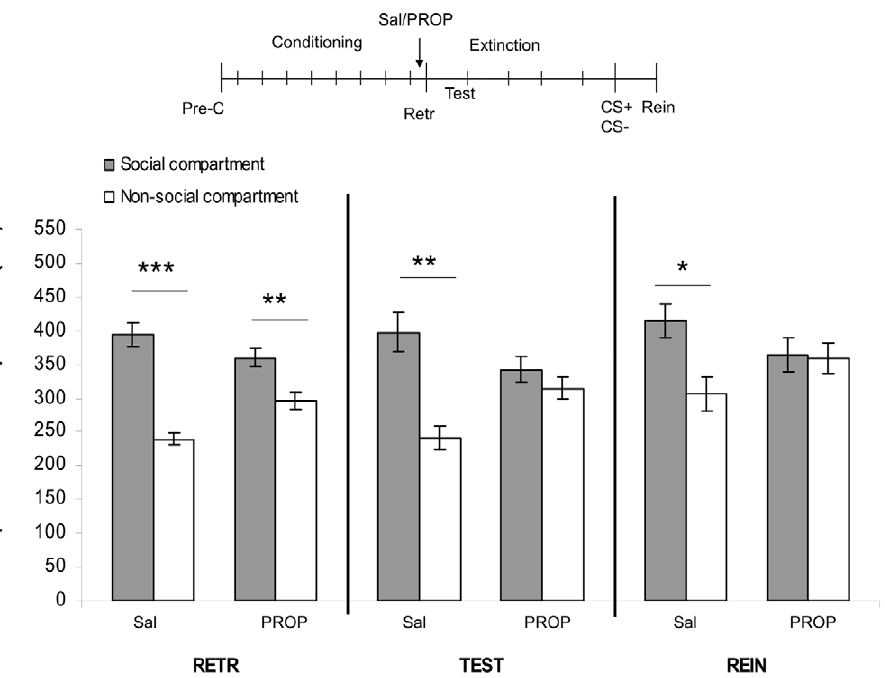
Figure 4. Effects of PROP on memory-retrieval of social play-induced CPP. The experimental protocol is depicted above the graph (Pre-C: pre-conditioning test, CS + : conditioning session with a play-partner, CS-: conditioning session alone). Data represent the mean time (sec 6 SEM) spent in the social compartment (grey bars) and the non-social compartment (white bars) during 15 min retrieval- (RETR), test-(TEST) and reinstatement- (REIN) sessions. Saline-treated animals (2 ml/kg, i.p ., n=22), PROP-treated animals (10 mg/kg, i.p., n=15). Post-hoc Student’s paired t- tests for difference in time spent in the social- and non-social compartment *p , 0.05, **p , 0.01, ***p , 0.001.